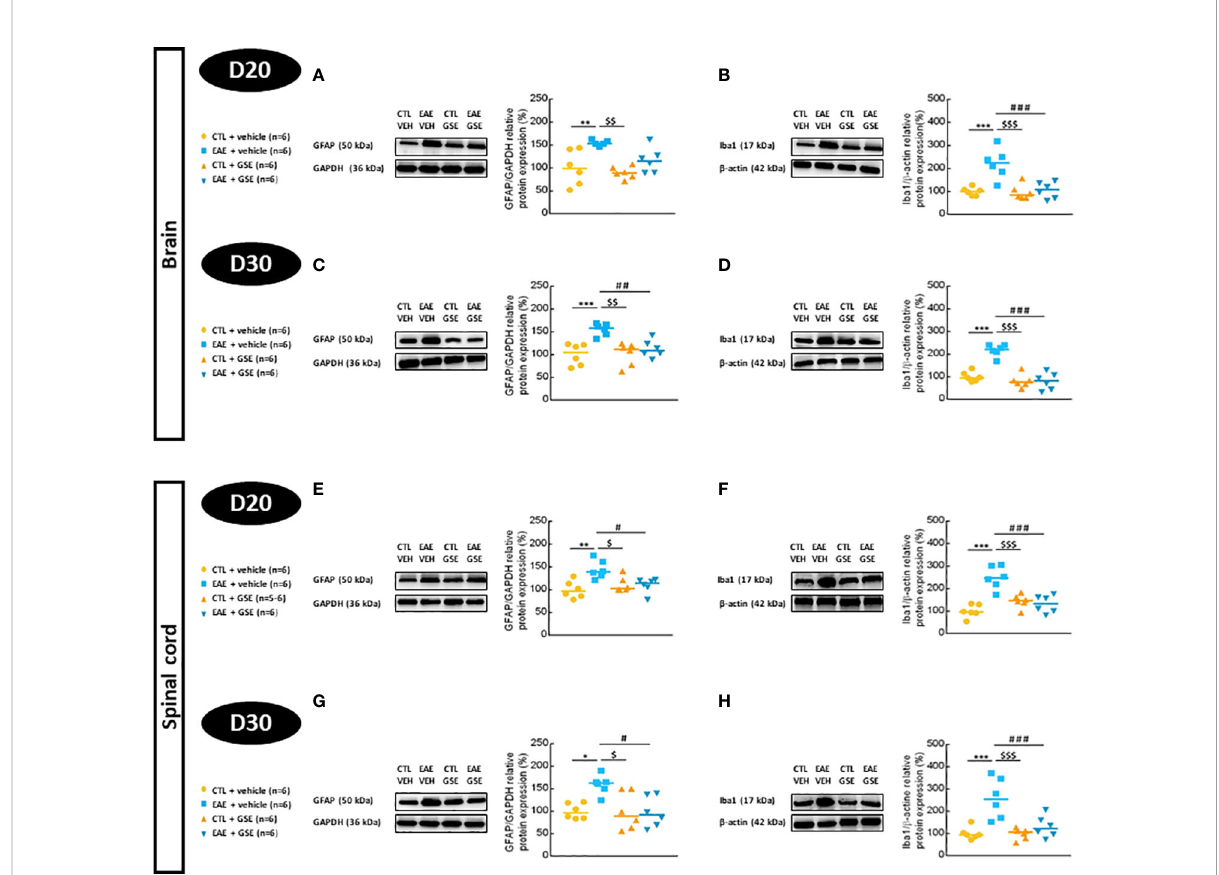
FIGURE 8 Evaluation of glial fi brillary acidic protein (GFAP) and ionized calcium-binding adaptor molecule 1 (Iba1) protein expressions in the brain and spinal cord of experimental autoimmune encephalomyelitis mice (EAE) and their controls (CTL) after curative treatment with grape seed extract (GSE) or vehicle. GFAP/GAPDH protein expression was expressed as the relative protein expression (%) compared to CTL + vehicle group, in the brain (A, C) and the spinal cord (E, G) at D20 (A, E) or D30 (C, G) post-induction. Iba1/ b -actin protein expression was expressed as the relative protein expression (%) compared to CTL + vehicle group, in the brain (B, D) and the spinal cord (F, H) at D20 (B, F) or D30 (D, H) post- induction. For each protein level quanti fi cation, a representative Western blotting image of the target protein and loading control is proposed. Statistical analysis was performed using one-way ANOVA followed by Tukey ’ s multiple comparison test: *p < 0.05, **p < 0.01, ***p < 0.001 EAE + vehicle vs CTL + vehicle; #p < 0.05, ##p < 0.01, ###p < 0.001 EAE + GSE vs EAE + vehicle and $p < 0.05, $$p < 0.01, $$$p < 0.001 EAE + vehicle vs CTL +